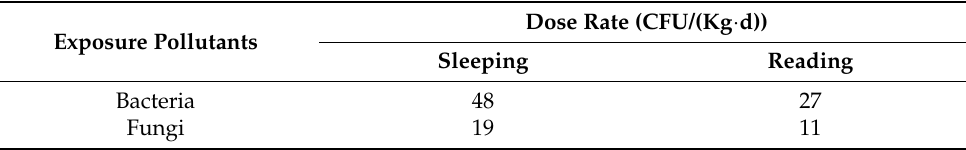
Table 2. Dose rate from exposure to bacteria and fungi in the female dormitory. Dose Rate (CFU/(Kg · d)) Exposure Pollutants Sleeping Reading Bacteria 48 27 Fungi 19